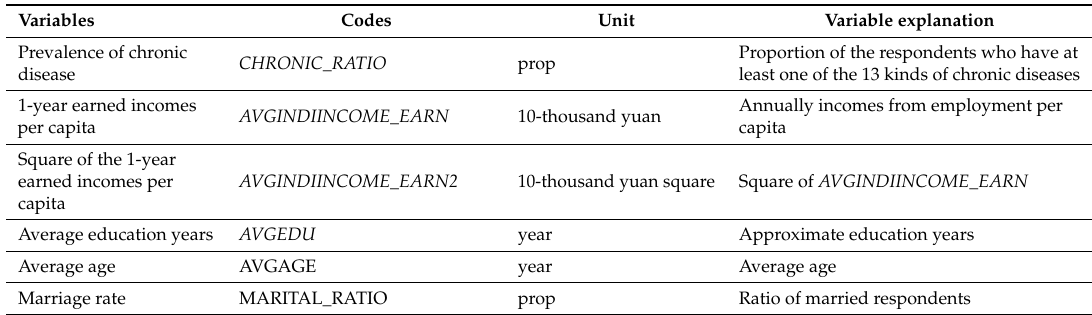
Table A1. Variable definitions of CHARLS